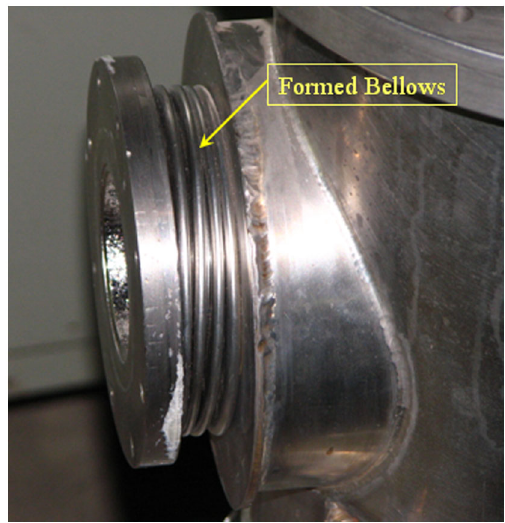
FIG. 13. (Color) Newly replaced formed bellows to join the niobium-SS transition flanges with the SS